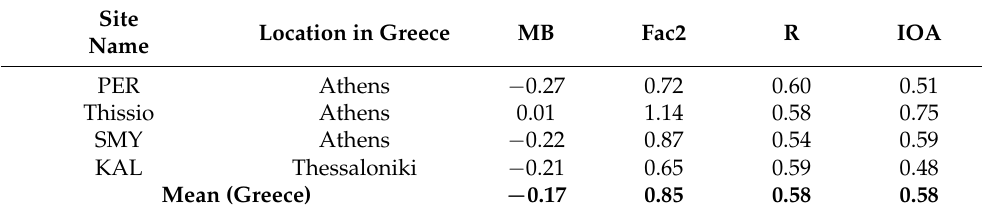
Table 3. Statistical metrics for CO mean daily concentrations (mg/m 3 ) for each monitoring site over Thessaloniki, Greece (for d03 domain, 2 × 2 km 2 ) and the rest of Greece (for d02 domain, 6 × 6 km 2 )